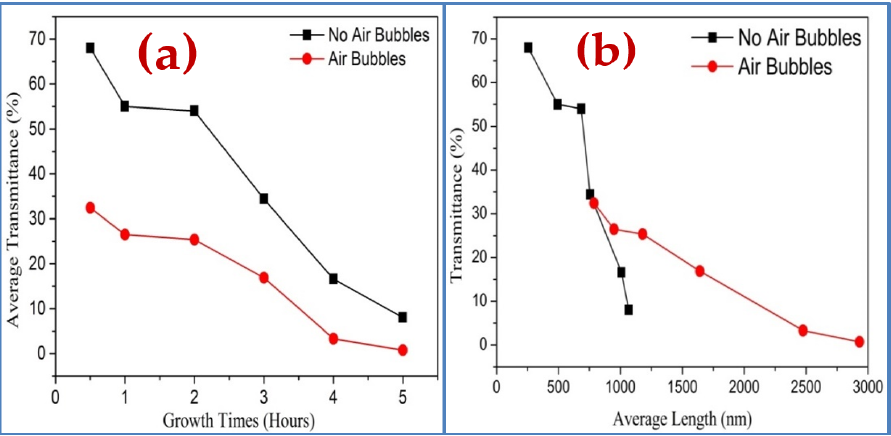
Figure 15. Optical transmittance spectrums of ZnO nanorods fabricated by two ways of preparation versus ( a ) different growth times and ( b ) average length of ZnO nanorods.